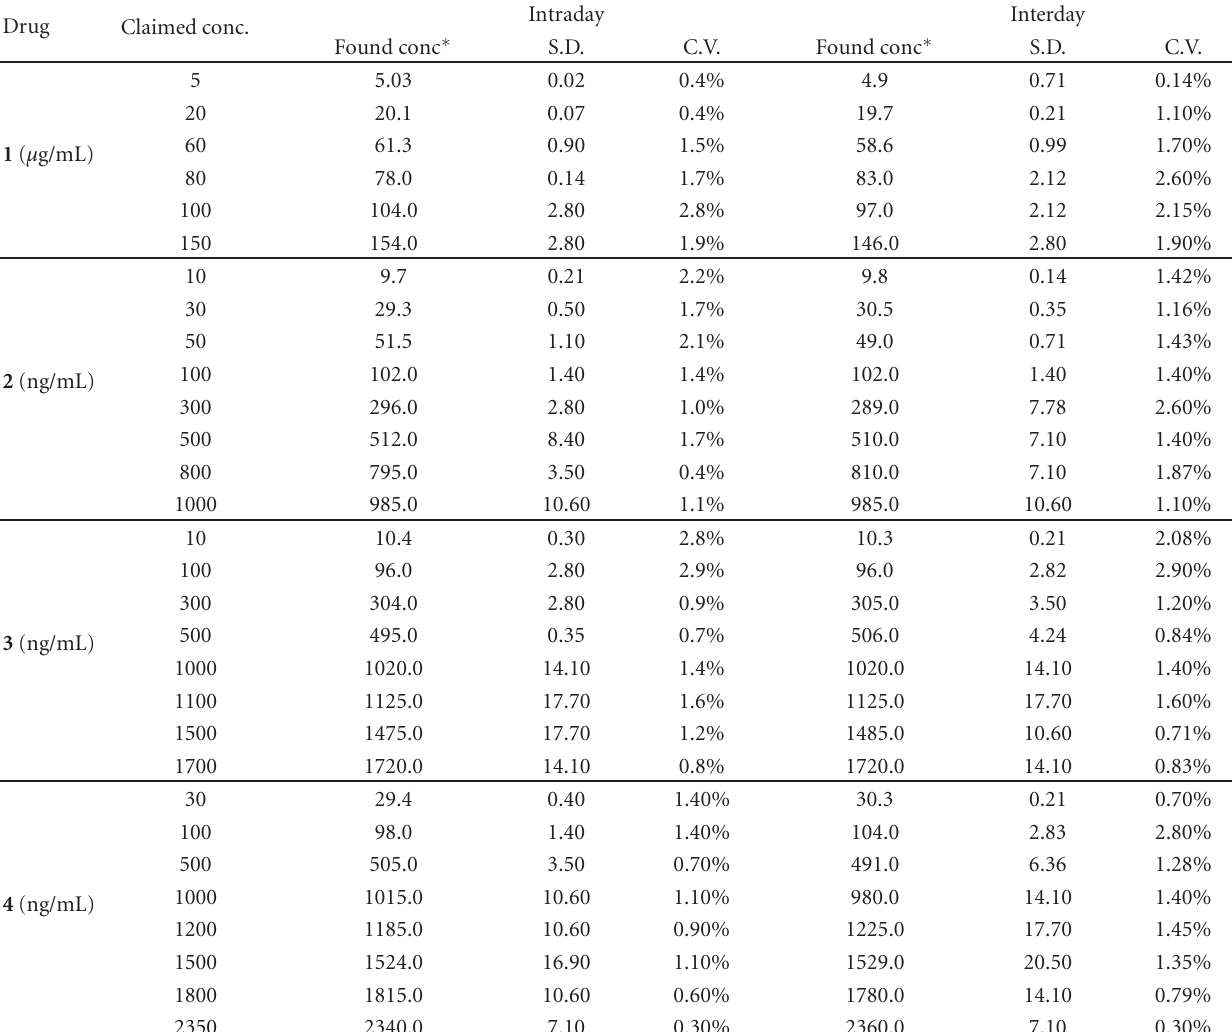
Table 5: Intraday and interday precision of 1–4 determination in plasma samples using the proposed method. Drug Claimed